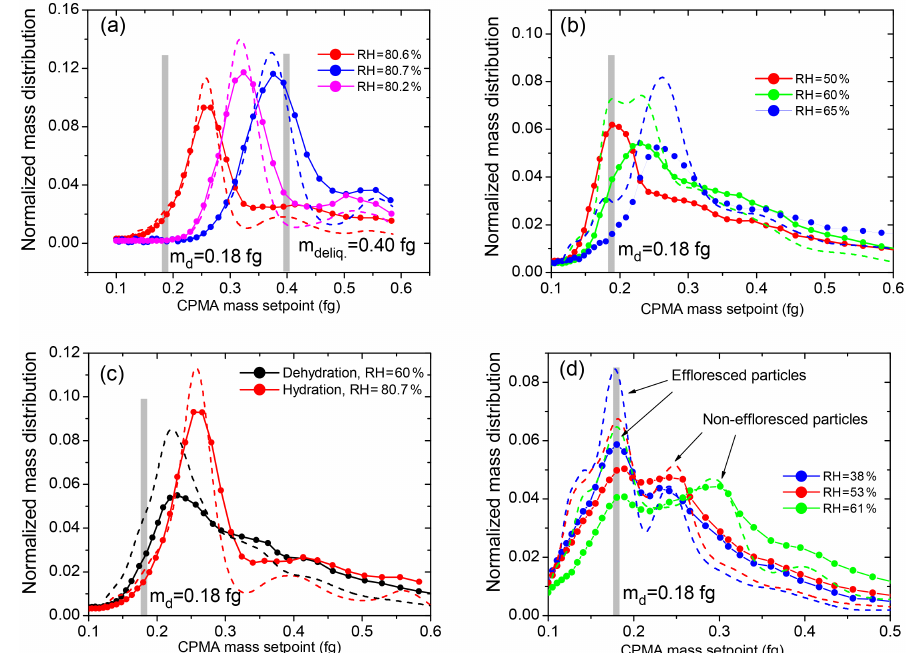
Figure 4. Normalized particle number mass distributions of ammonium sulfate particles with initial dry modal mass m d = 0 . 18fg measured at RH close to the deliquescence and efflorescence thresholds of (a) unimodal intermediate mass distributions observed near the DRH, m deliq . = 0 . 40fg is the mass of fully deliquesced particles; (b) unimodal and (d) bimodal mass distributions observed for particle dehydration at RH<65%; (c) mass distribution broadening for particle hydration (red), and dehydration (black). The RH uncertainty was estimated to be ± 1.5%. Symbols and solid lines are normalized experimental averaged mass spectral density (cid:49)N/(N(cid:49) log (m)) . Dashed lines are mass- based distribution function d n/(N dlog (m)) after application of an inversion procedure to the primary data.